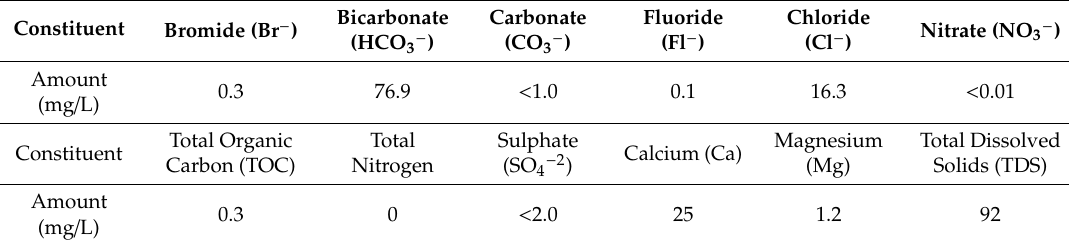
Table 2. Composition of tap water used in testing [53].